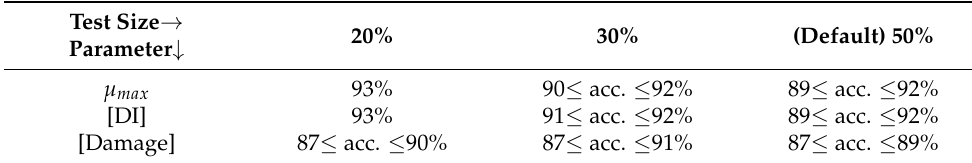
Table 4. Highest accuracies achieved in the supervised learning of the most-important parameters that efficiently estimate the outputs: the case when all six direct inputs are used.